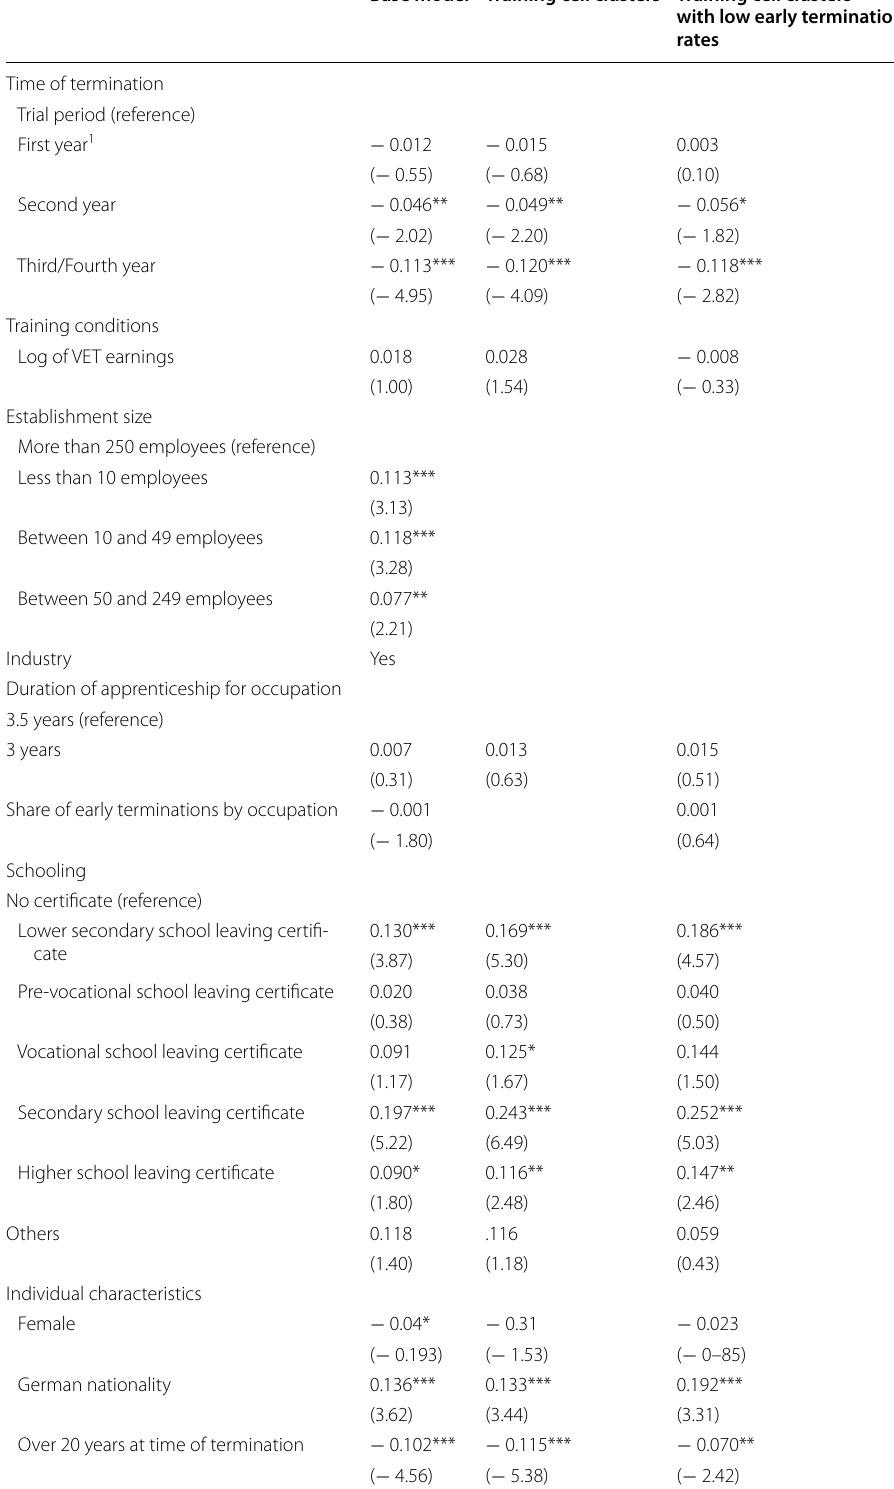
Table 2 Logit model for the probability of undertaking a new VET programme after early termination (marginal